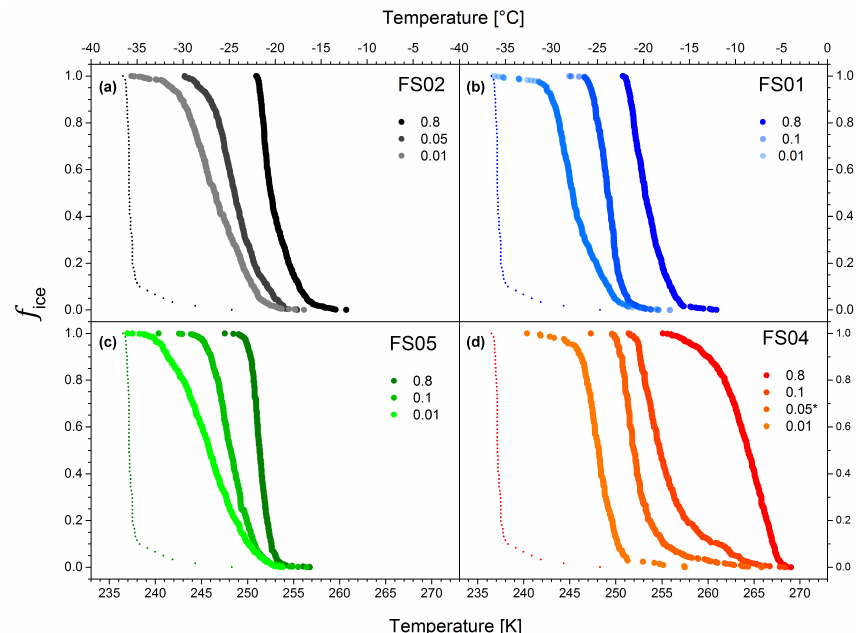
Figure 5. Frozen fraction curves of feldspar suspensions with various concentrations for (a) FS02, (b) FS01, (c) FS05, and (d) FS04 samples. Suspension concentration is given in the legend of each plot in wt%. Frozen fraction curves for Nanopure water droplets on a clean silicon wafer are indicated by the dotted line on each plot. All curves were measured with a cooling rate of − 1Kmin − 1 except for FS05 0.05wt%, for which the cooling rate was − 5Kmin − 1 (marked with an asterisk). Note the initiation of freezing at 268K for FS04 0.8wt% suspension